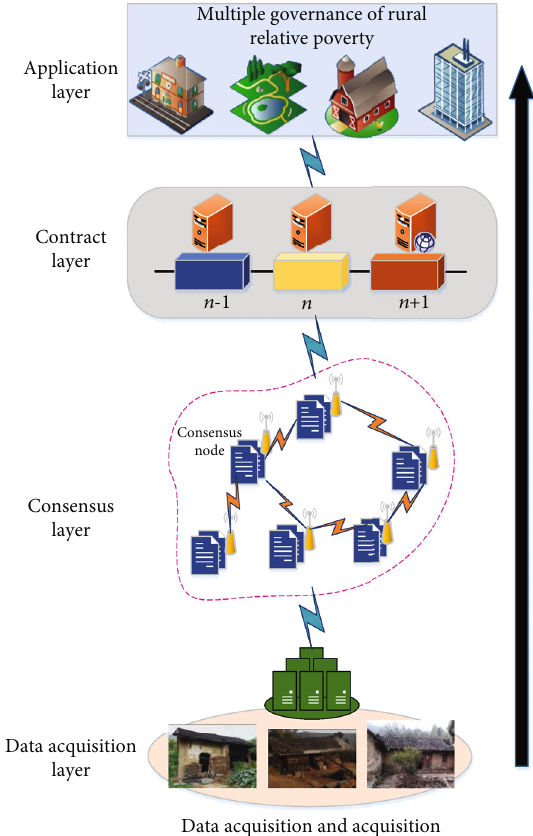
Figure 3: Schematic diagram of rural relative poverty data governance architecture based on blockchain